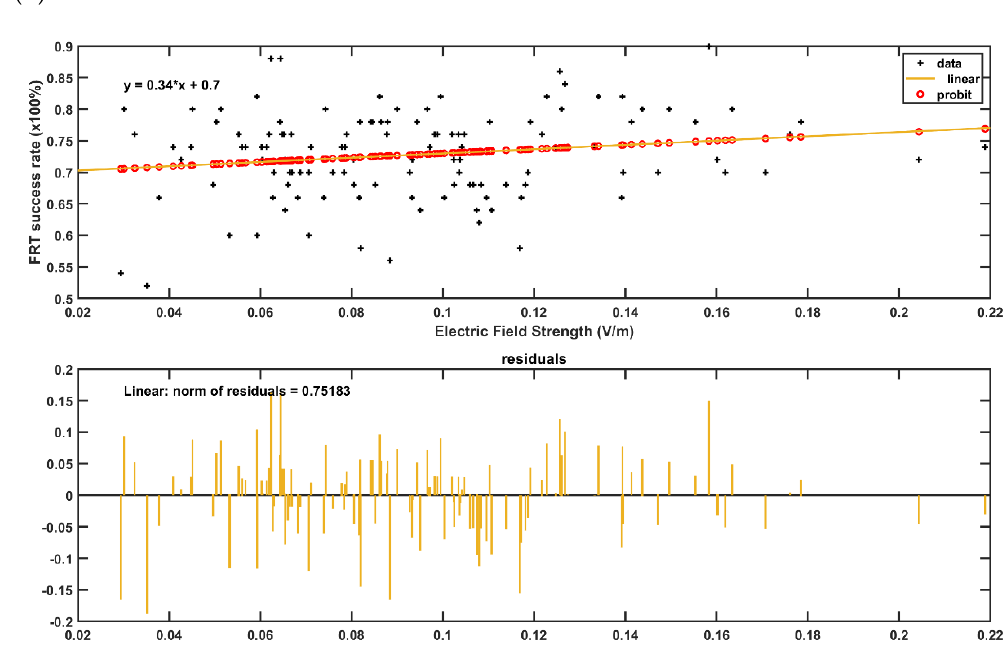
Figure 8. ( a ) and ( b ) GLM model (with probit link) for the post-intervention FRT success rate (%) with the lobular maximum electric field strength as the predictor in ( a ), and with the lobular median electric field strength as the predictor in the ( b ). The plot shows the observed and estimated the FRT success rate (%) versus the predictor values as well as the residuals where the FRT success rate (%) found to be more sensitive to lobular median electric field strength (slope 0.17—Figure 8b) than the lobular maximum electric field strength (slope 0.09—Figure 8 a ). ( c ) and ( d ) GLM model (with probit link) for the post-intervention FRT success rate (%) with the median electric field strength in dentate nuclei as the predictor in the c ), and with the median electric field strength in the bilateral cerebellar leg area lobules as the predictor in the ( d ). The plot shows the observed and estimated the FRT success rate (%) versus the predictor values as well as the residuals where the FRT success rate (%) found to be more sensitive to the leg area lobular median electric field strength (slope 0.34—Figure 8d) than the dentate nuclei median electric field strength (slope 0.27—Figure 8c).